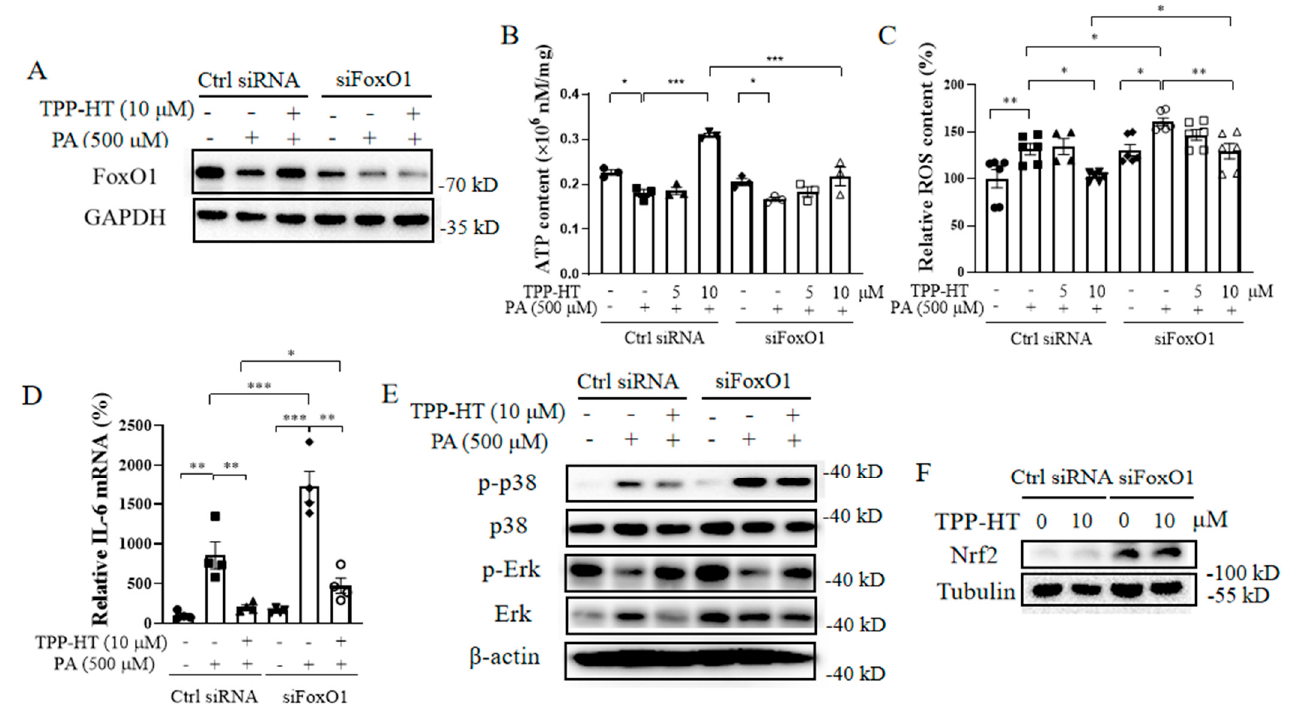
Figure 5. FoxO1 partially mediates the TPP-HT prevention of PA-induced ATP drop, ROS generation and inflammation in HAECs. Ctrl siRNA- or FoxO1 siRNA-transfected HAECs were treated with TPP-HT for 24 h and then treated with or without PA at 500 μ M for another 24 h. ( A ) Protein levels of FoxO1. ( B ) ATP content. ( C ) ROS content. ( D ) mRNA level of IL-6. ( E ) Protein levels of p-p38, p38, p-Erk and Erk. ( F ) Protein levels of Nrf2. Values are the mean ± SEM from at least three independent experiments. * p < 0.05, ** p < 0.01, *** p < 0.001.